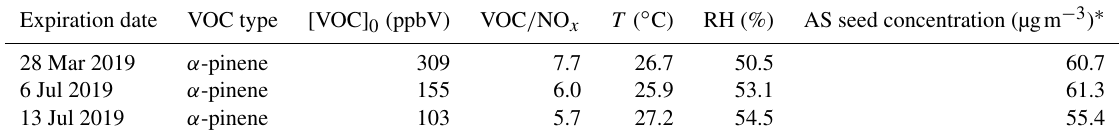
Table 4. Summary of initial conditions for α -pinene photochemistry